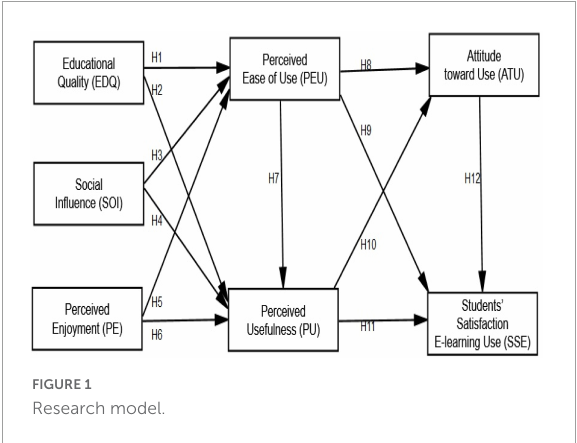
FIGURE1 Research